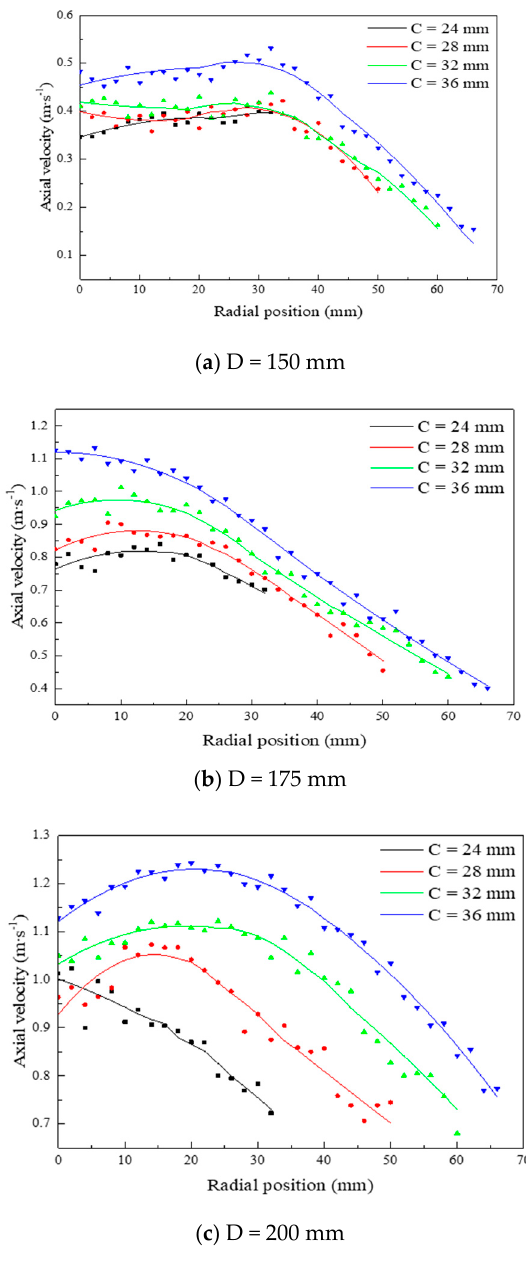
Figure 7. Axial flow velocity distribution on a horizontal line at 6 mm below the impeller blade bottom at varying impeller diameters (D) and impeller off-bottom clearances (C).